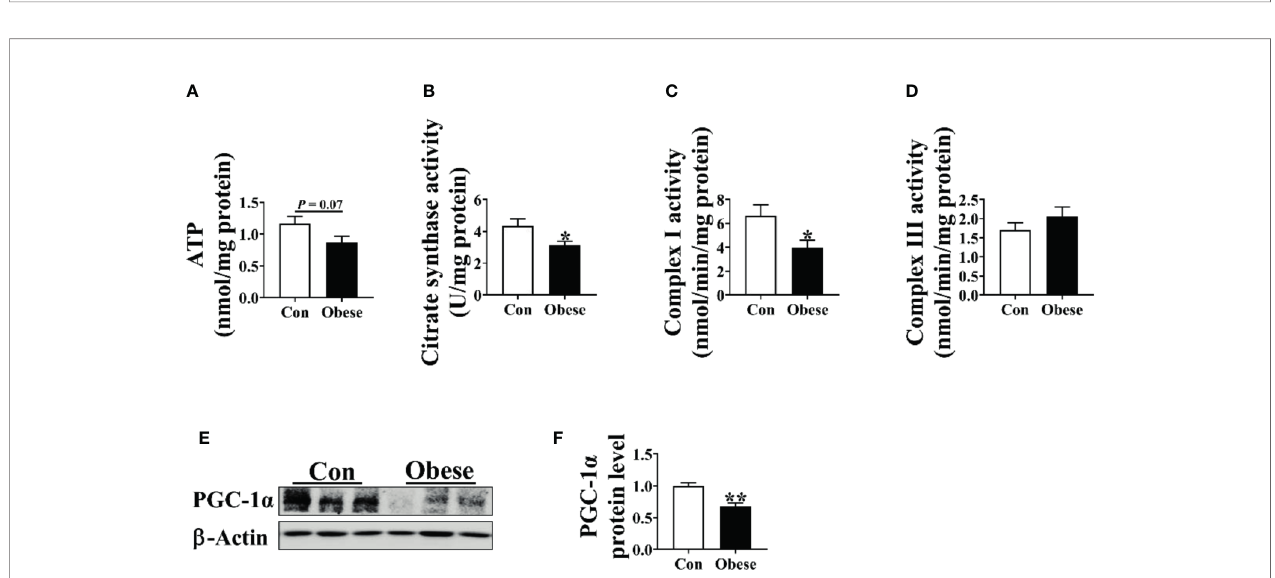
FIGURE 4 | Mitochondrial function in placentae. Mitochondrial function was estimated by ATP (A) level, citrate synthase (B) , Complex I (C) , and III (D) activities. The protein level of PGC-1 a in placentae (E, F) . Values are mean ± SEM, n = 8. “ * ” and “ ** ” indicate P < 0.05 and < 0.01, respectively.